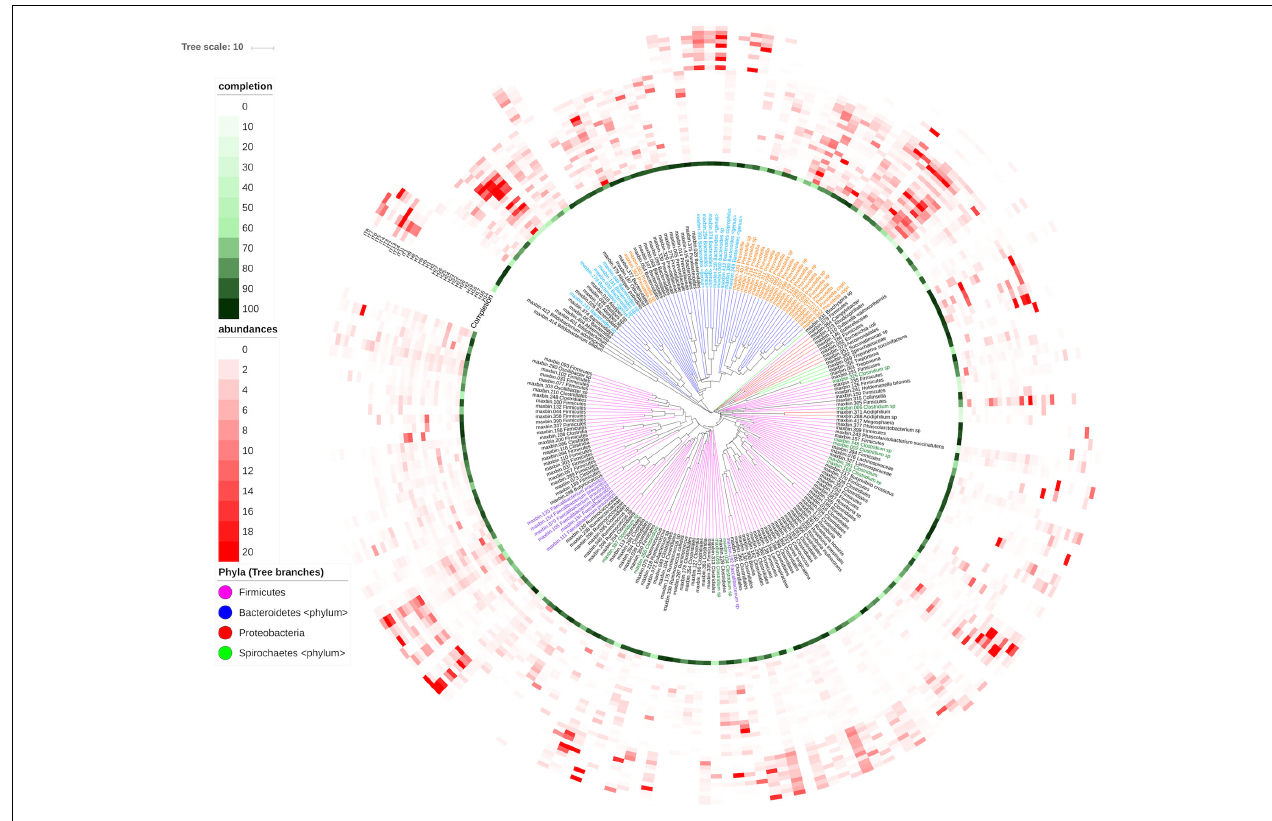
FIGURE 4 | Abundance of bins in the diverse samples. Bins were compared with the CompareM software (https://github.com/dparks1134/CompareM) to estimate their reciprocal similarities. The distances calculated between the bins were used to create a phylogenetic tree illustrating their relationships. The tree is shown in the inner part of the Figure. Branches in the tree corresponding to the four more abundant phyla in the tree (Firmicutes, Bacteriodetes, Proteobacteria, and Spirochaetes) were colored. Bins were named with their id number and original genera, and labels for the most abundant genera were also colored. Outer circles correspond to: the completeness of the bins (green-colored, most internal circle), and the abundance of each bin in each sample (red-colored). Each circle corresponds to a different sample (H, Hadza; I, Italians), and the red color intensities correspond to the bin’s abundance in the sample. The picture was prepared using the iTOL software